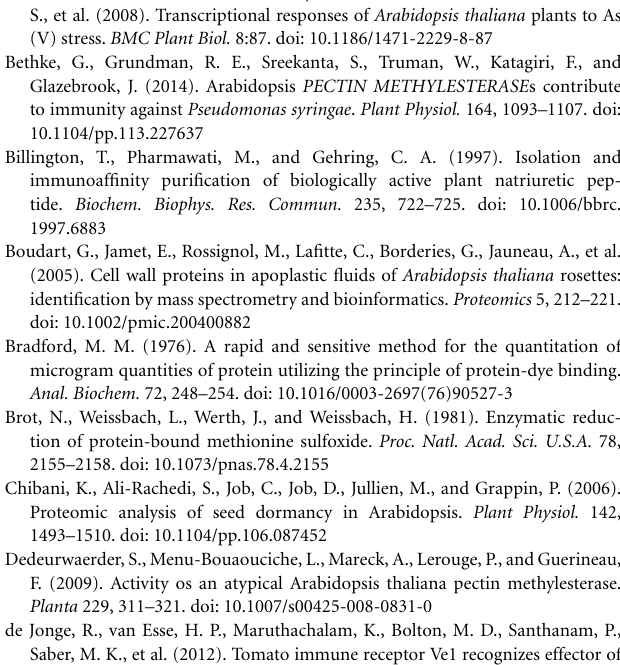
Figure S1 | Overview of PNP-A domains. Figure S2 | Overview of TMT experiment. Figure S3 | Overview of MS data analysis. Table S1 | 1nM AtPNP treatment. Table S2 | 10 pM AtPNP treatment. Table S3 | Key to 1nM AtPNP-A treatment spectra. Table S4 | Key to 10 pM AtPNP-A treatment